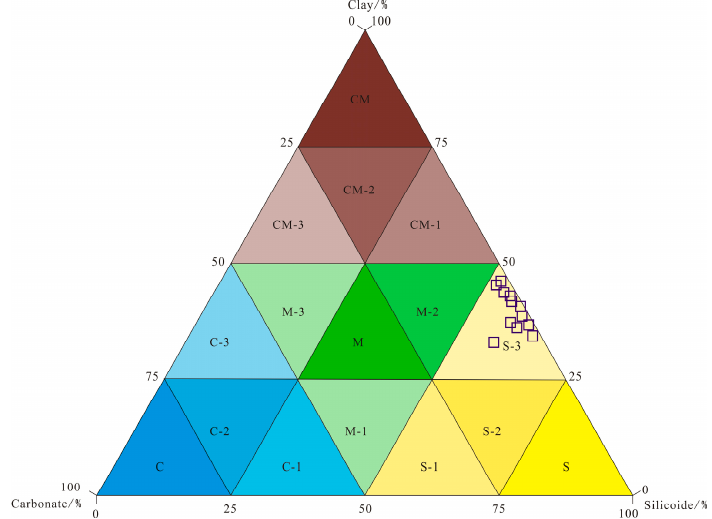
Figure 10. The ternary diagram of mineral composition for dividing lithofacies. S: siliceous shale